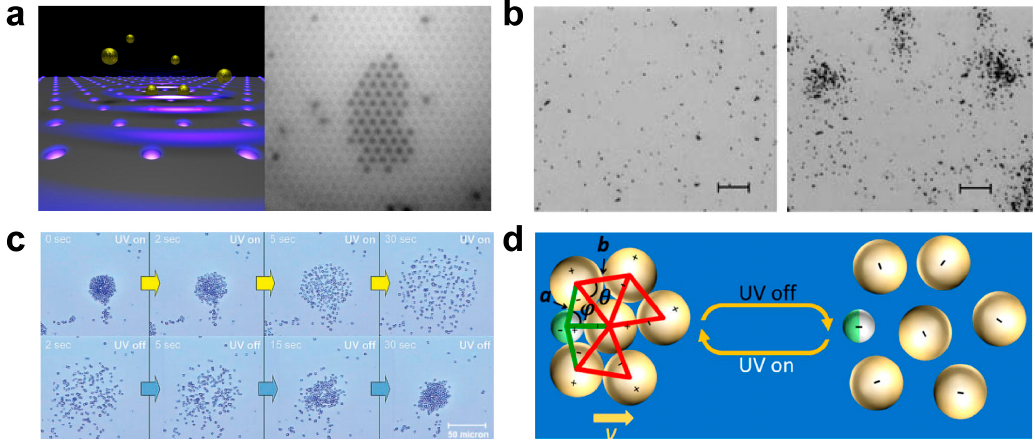
Figure 6. Light induced swarming and assembly of micro/nanoparticles. ( a ) Optical analogue of epitaxial growth to assemble gold nanoparticles (reproduced from [86]). ( b ) Schooling behavior of light-powered AgCl micromotors (reproduced from [87]). ( c ) Titanium-dioxide-based reversible micropump systems (reproduced from [88]). ( d ) TiO 2 /Pt Janus micromotors with light irradiation for reversible and in-place assembly dissociation of surrounding SiO 2 particles (reproduced from [89]).